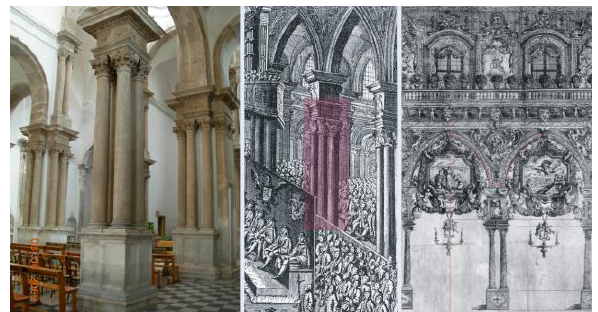
Figure 3: The ‘tetra-pillars’ in San Giorgio dei Genovesi and two historical drawings displaying the tetra-pillars of the cathedral.